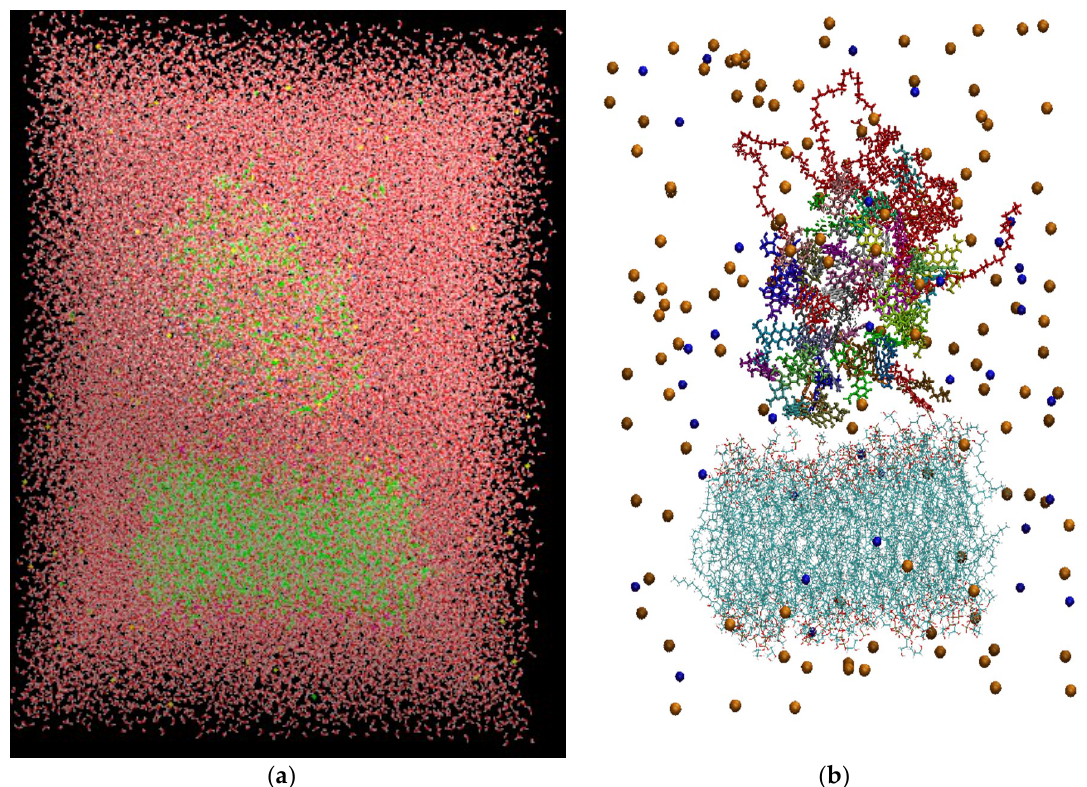
Figure 3. ( a ) The constructed system including water molecules (shown in red-white). ( b ) The same system without the water molecules. Blue beads represent the chlorine ions and orange beads the sodium ions. Each drug molecule is shown in different color and in rod representation, while the PEGylated hyperbranched molecule is shown in red color. In the lower part of the snapshot, the lipids of the membrane are shown in wire representation.